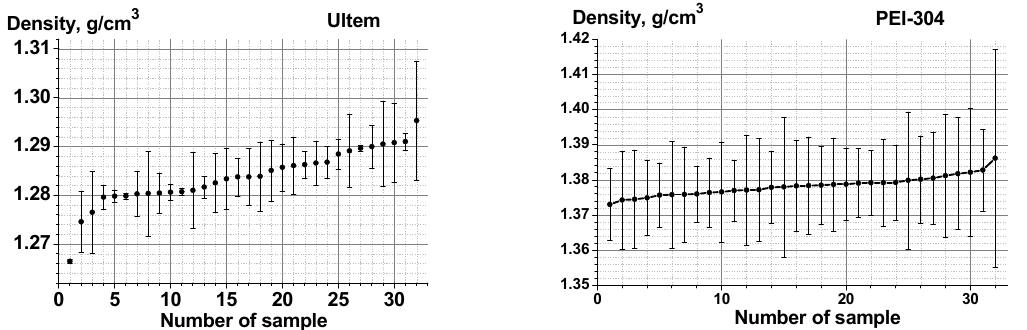
Figure 2. Density of the prepared samples sorted according to their increasing density, Ultem ( left ), PEI-304 ( right ). The bars indicate the standard deviation along the equilibrium trajectories.